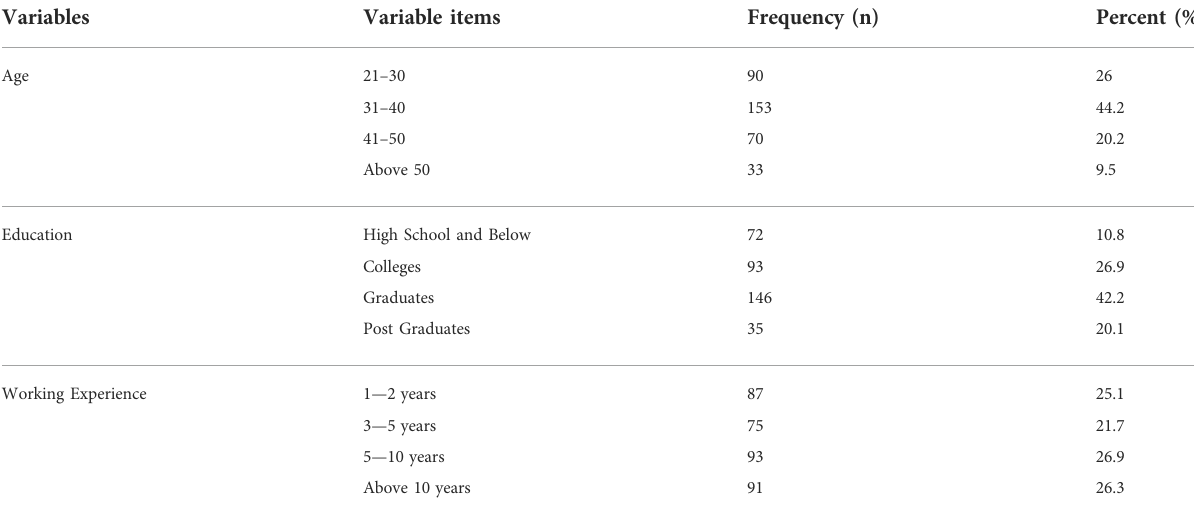
TABLE 1 Descriptive statistics.